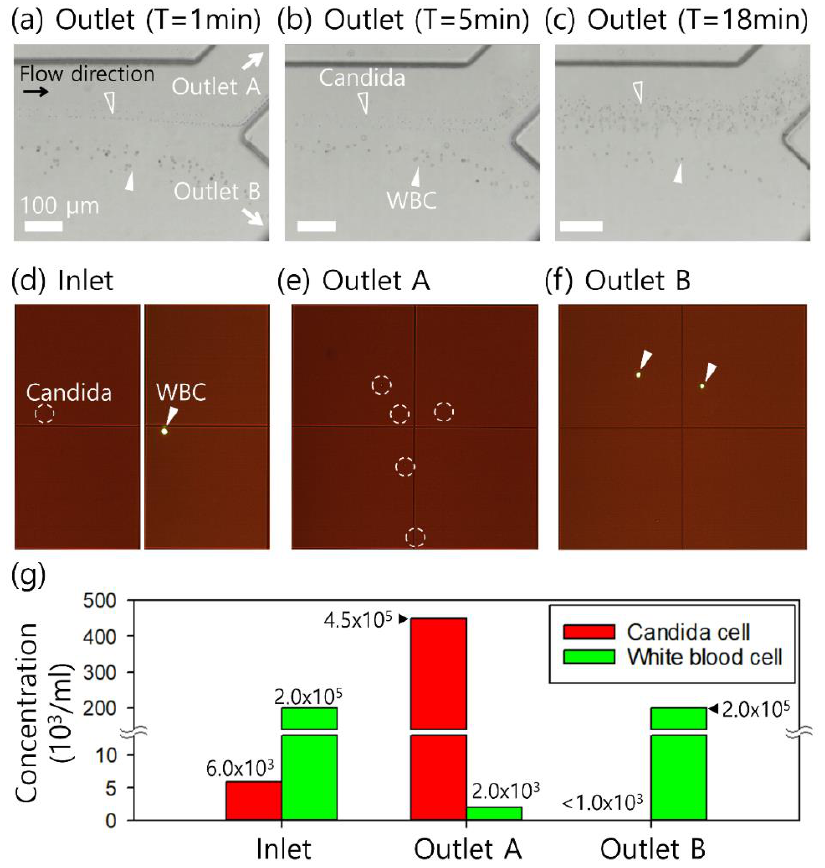
Figure 3. Stacked microscopic images showing viscoelastic closed-loop separation and concentration of Candida cells from white blood cells at a flow rate of 800 µ L/min with FF = 3.3 at the ( a ) outlet at time T = 1 min, ( b ) outlet at time T = 5 min, and ( c ) outlet at time T = 18 min. Microscopic images of the 1:10 diluted sample before and after the closed-loop separation and concentration process at the ( d ) inlet, ( e ) outlet A, and ( f ) outlet B for manual counting. ( g ) Concentration of Candida cells and white blood cells at the inlet and outlet A and B.